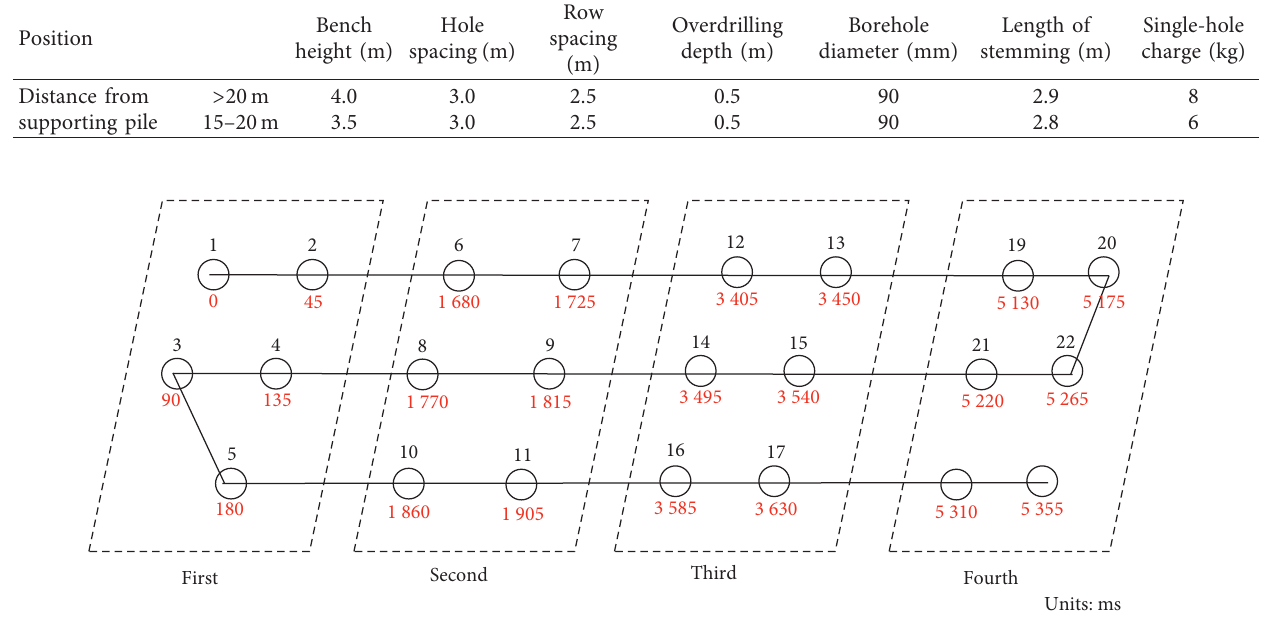
Figure 2: Time-delayed blasting of the electronic detonator network.